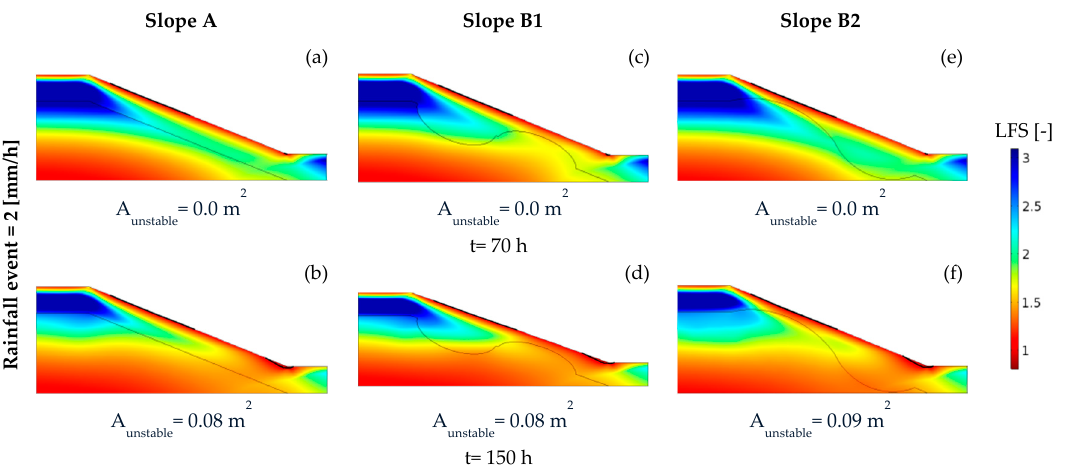
Figure 13. The temporal development of the LFS distribution for a 150-h rainfall event with an intensity of 2 mm per hour for the 2D slope with a constant soil depth (slope A) at ( a ) t = 70 h and ( b ) t = 150 h and the 2D slope with a variable soil thickness (Slope B1 and B2) at ( c , e ) t = 70 h and ( d , f ) t = 150 h. Black contour lines indicate areas with LFS < 1.0.